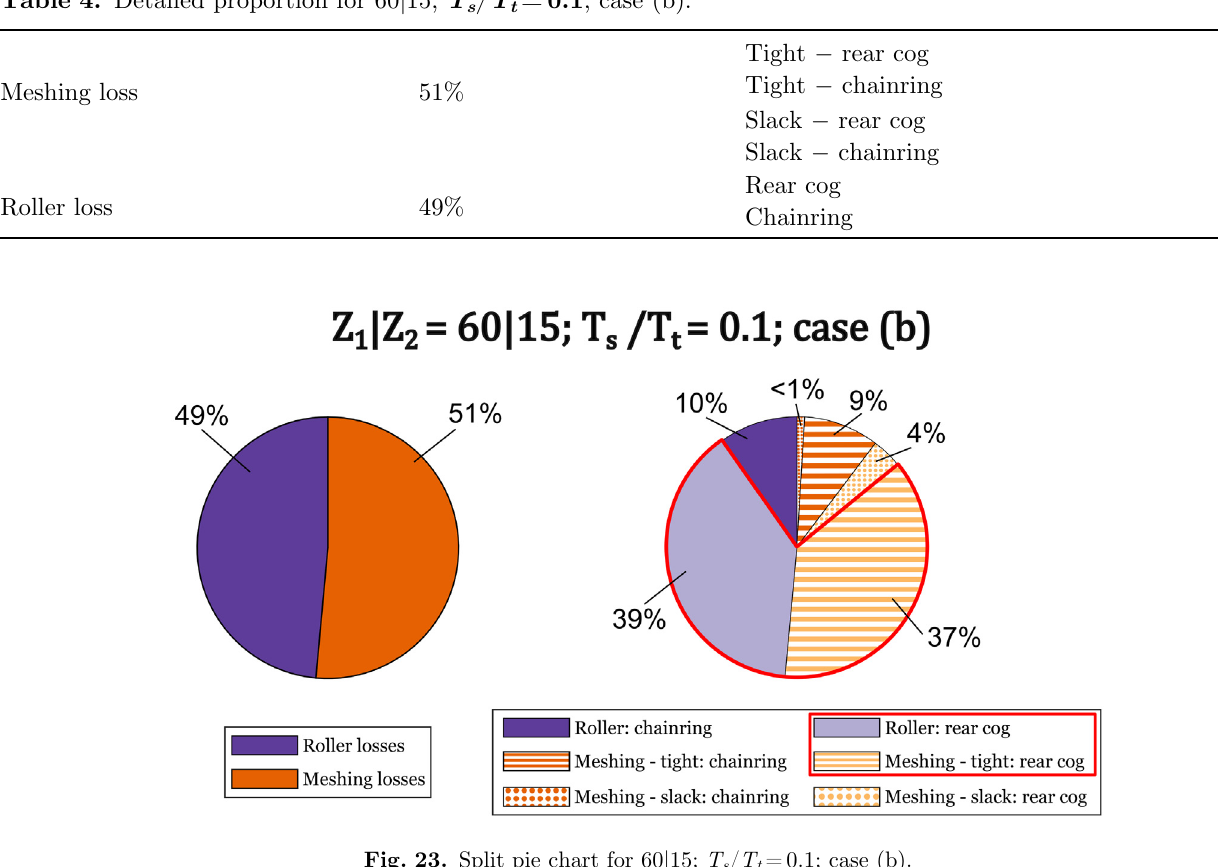
Fig. 23. Split pie chart for 60|15; T s / T t =0.1; case